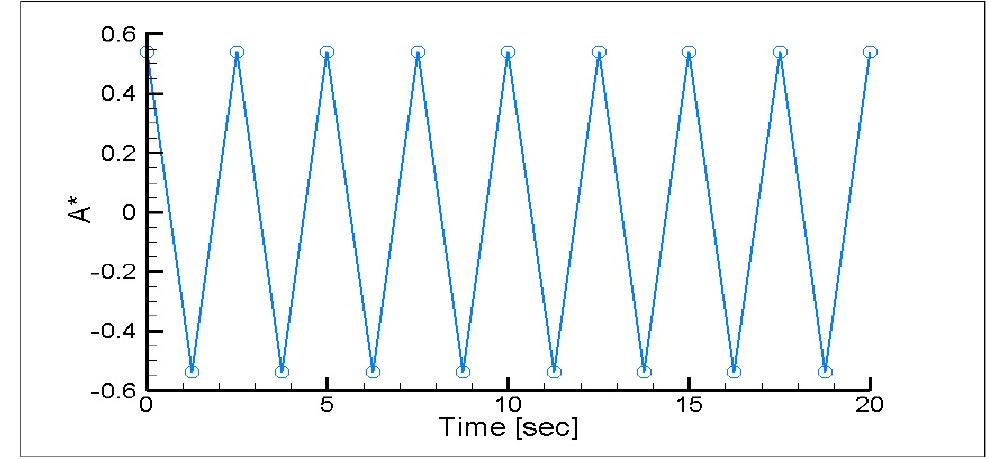
Figure 8. Amplitude response captured by Arduino.